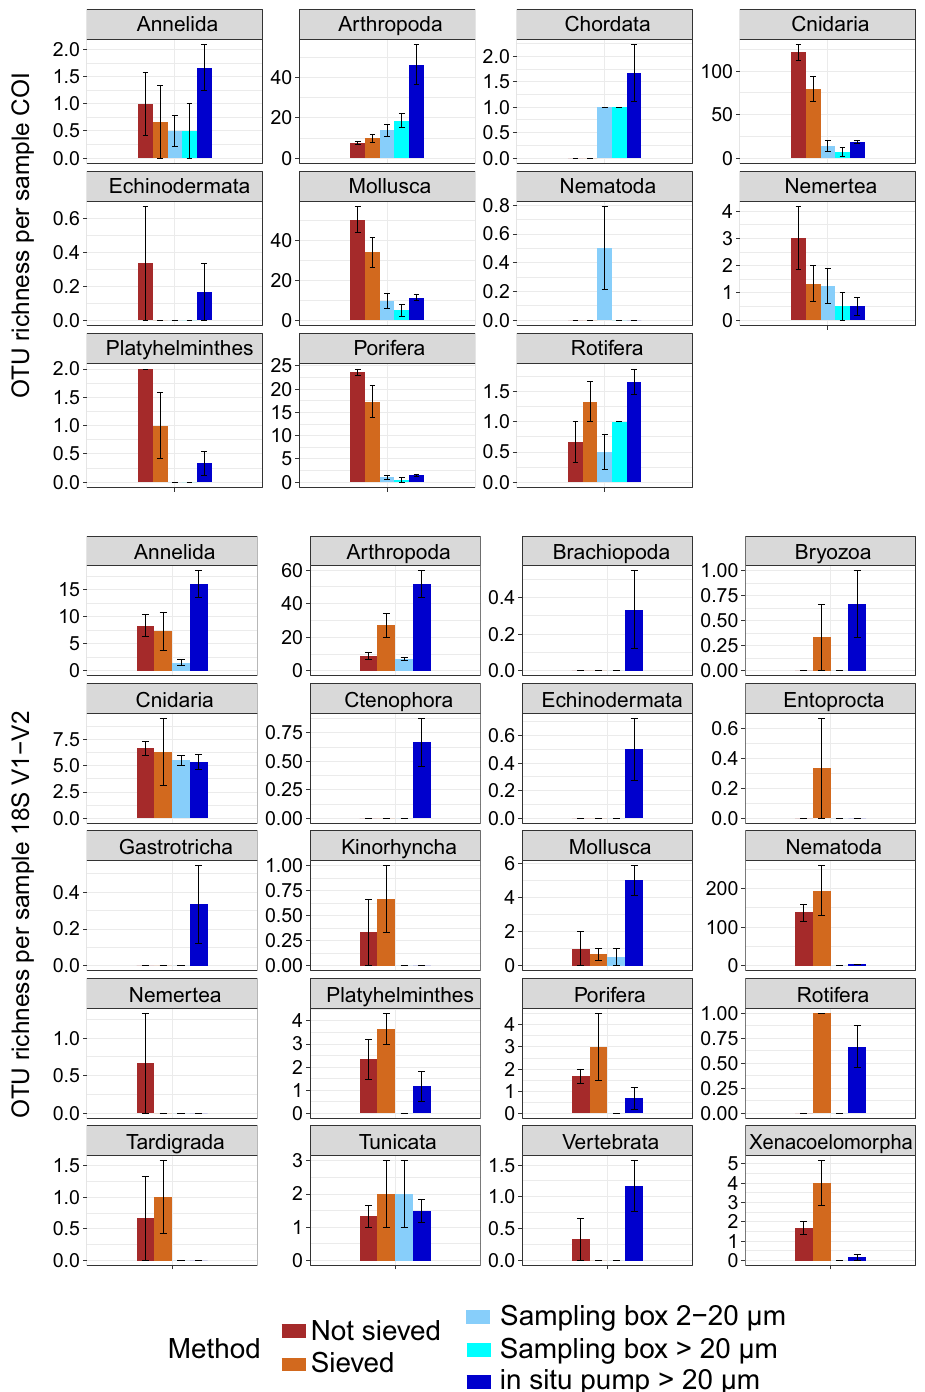
Figure 2. Mean numbers (± SE) of metazoan COI and 18S V1-V2 OTUs detected in target phyla for sediment (brown) and water (blue), using two sampling methods for both sample types. Sediment was either sieved to size-sort organisms prior DNA extraction, or DNA was extracted directly from crude sediment samples. Water was collected with a 7.5 L sampling box, allowing recovery of two size classes, or sampled in large volumes with an in situ pump. OTU numbers were calculated on rarefied